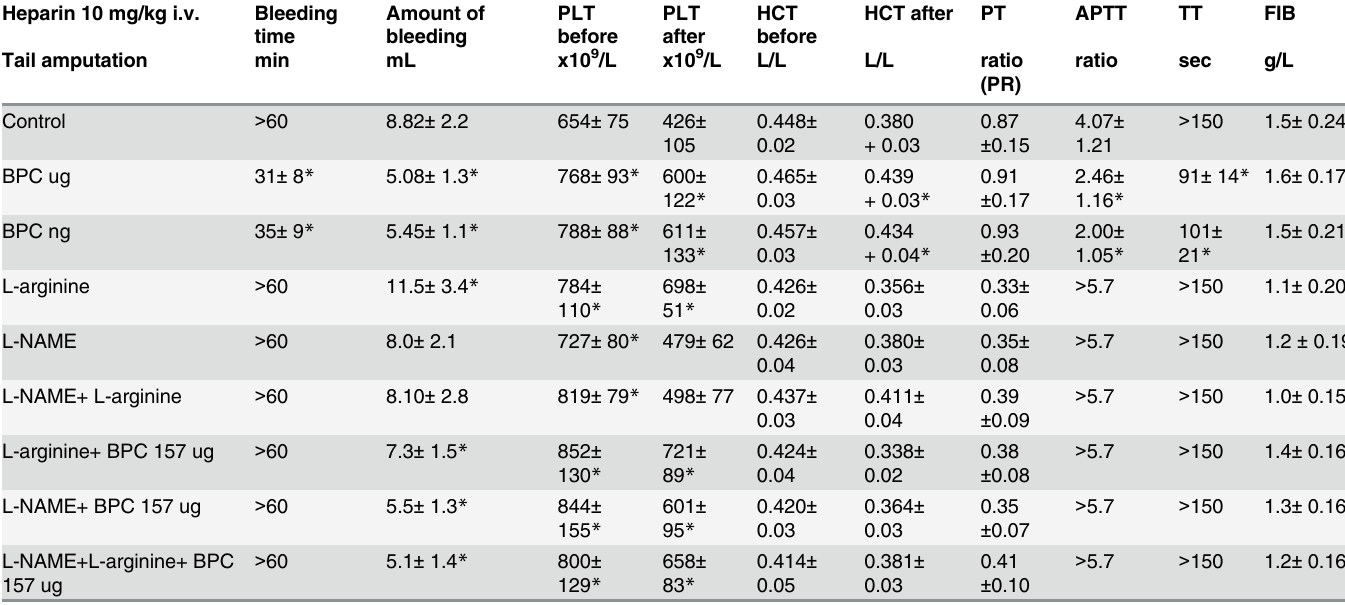
Tail amputation, bleeding time, amount of bleeding, PLT, HCT, PT, APTT, TT, FIB values in heparin (10 mg/kg intravenously) challenged rats (10 rats at least per group) when treated with BPC 157 (10 μ g/kg, 10 ng/kg), L-NAME (5 mg/kg), L-arginine (100 mg/kg) alone or combined,